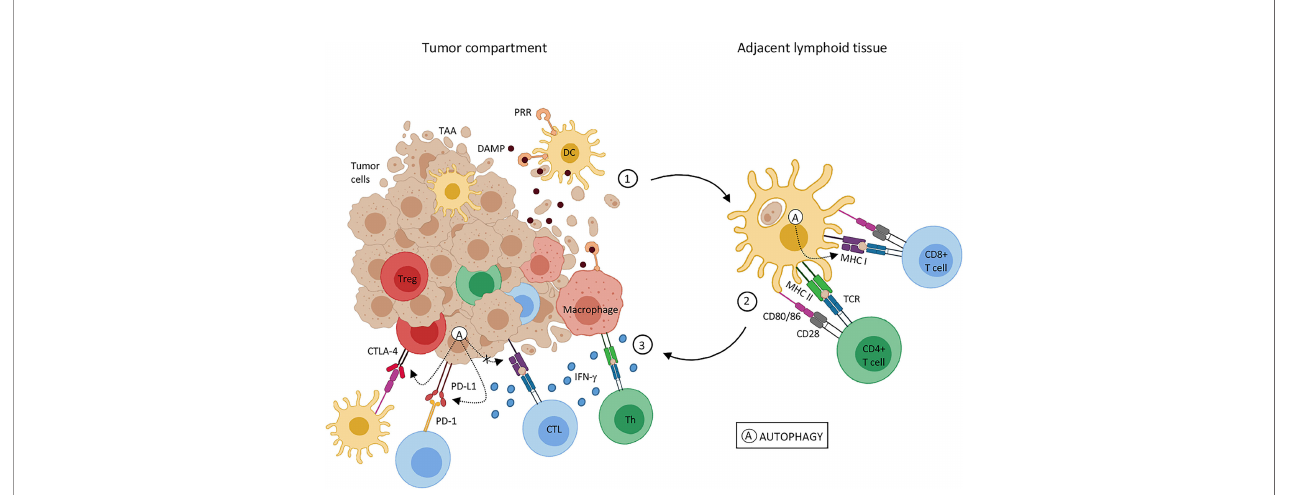
FIGURE 2 | Effects of tumor cell death on tumor-associated antigen presentation. Tumor-associated antigens (TAA); dendritic cells (DC); major histocompatibility complex (MHC); damage-associated molecular pattern (DAMP); cytotoxic T lymphocytes (CTL); T regulatory cells (Treg); pattern recognition receptor (PRR); T-cell receptor (TCR); helper T cell (Th); tumor necrosis factor (TNF); programmed cell death protein 1 (PD-1); programmed cell death-ligand 1 (PD-L1). Reprinted with permission from ref (69). copyright © 2020 de Souza, Gonc ̧ alves, Lepique and de